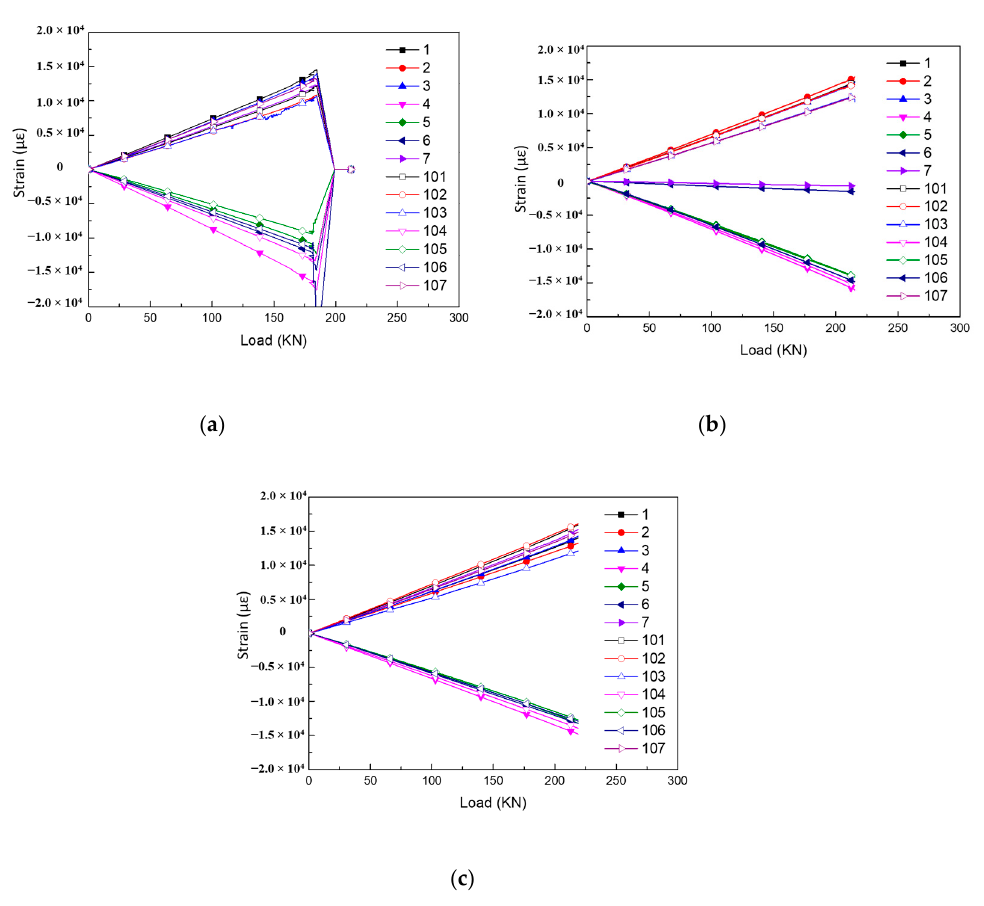
Figure 15. Shear strain vs. load curves of each specimen at the positions of strain gauge: ( a ) 01# specimen; ( b ) 02# specimen; ( c ) 03# specimen. Molecules 2019 , 24 , 4248 Table 3. Shear strain extremes on composite skins corresponding to failure load.